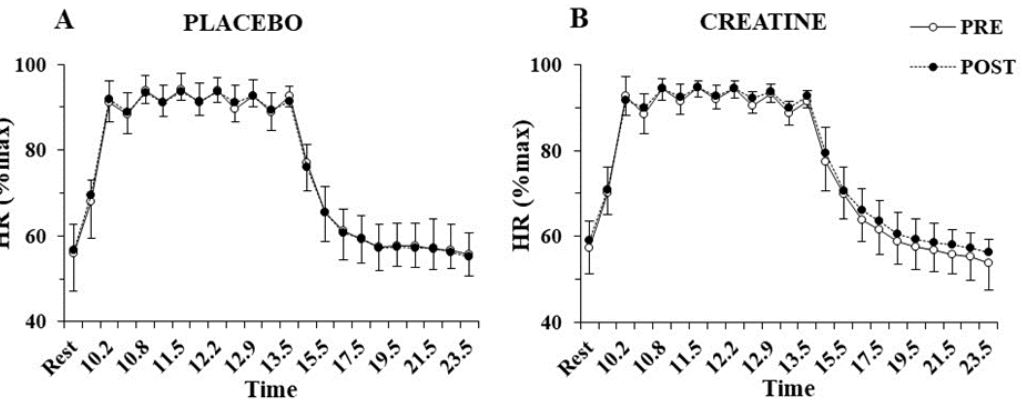
Figure 4. Heart rate (HR) percentage of maximum HR at rest, before and after each sprint, and following 10 min of recovery, pre- and post-supplementation for the placebo ( A ) and the creatine group ( B ).